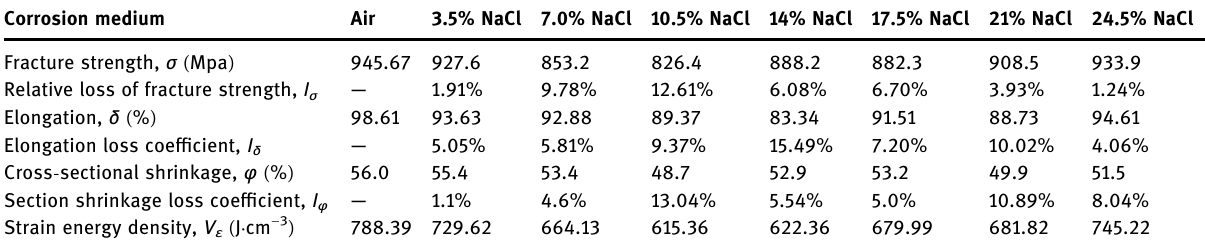
Table 3: SSRT experimental data and relative loss calculation results of high manganese steel Corrosion medium